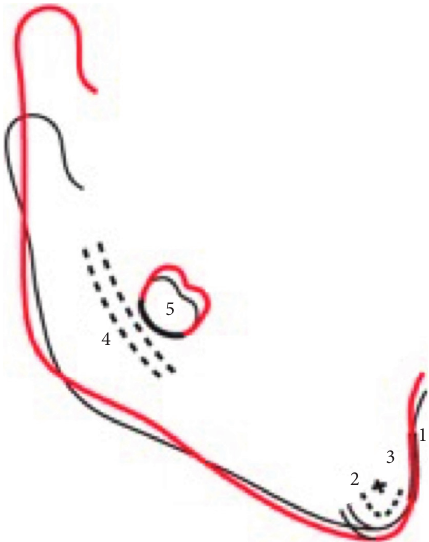
Figure 2: Example of 2D mandibular superimposition.